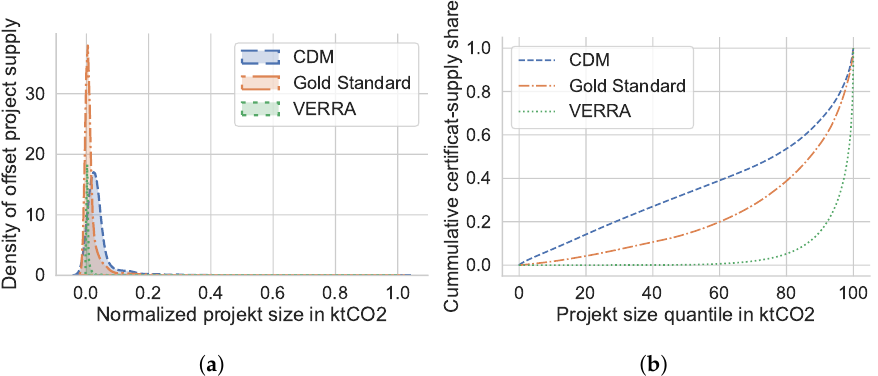
Figure 4. Distribution of carbon offset supply by project size. Notes: Panel ( a ) shows the distribution of the normalizes project size measured in ktCO 2 for CDM, Gold Standard and VERRA. Panel ( b ) shows the share of different project sizes for the total total supply for for CDM, Gold Standard and VERRA. Source: Own calculation.